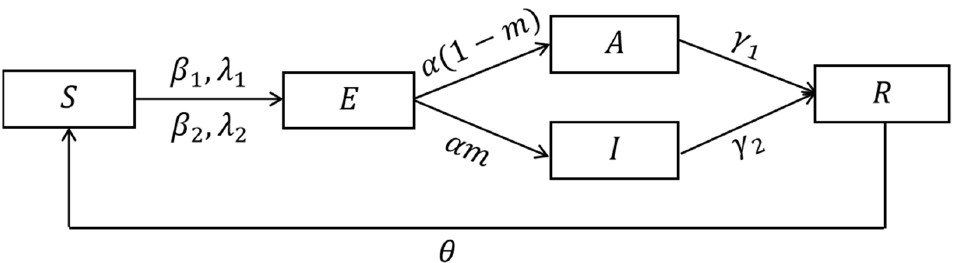
Figure 3. Flow diagram of a conventional SEIARN model chamber.